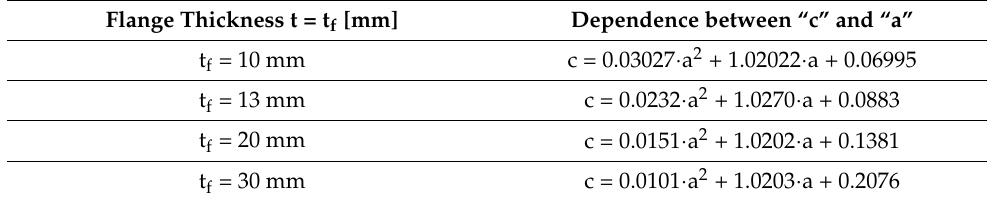
Table 5. Relationships between “c” and “a” depending on various flange thickness t f . Flange Thickness t = t f